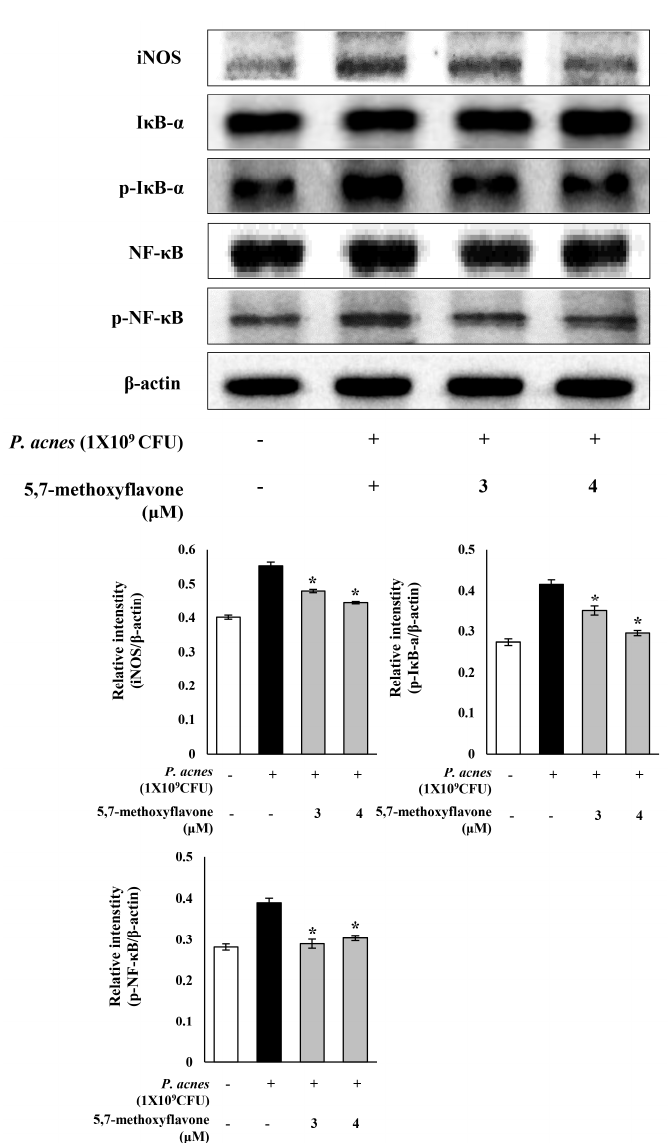
Figure 4. Inhibitory effect of 5,7-methoxyflavone on the Propionibacterium acnes -induced expression of inflammatory proteins in P. acnes -stimulated human keratinocyte (HaCaT) cells. The expressions of iNOS, p-I κ B α and p-NF- κ B were analyzed with ImageJ and normalized against β -actin. All data are expressed as mean ± SD. * p < 0.05 compared to P . acnes treated cells only.